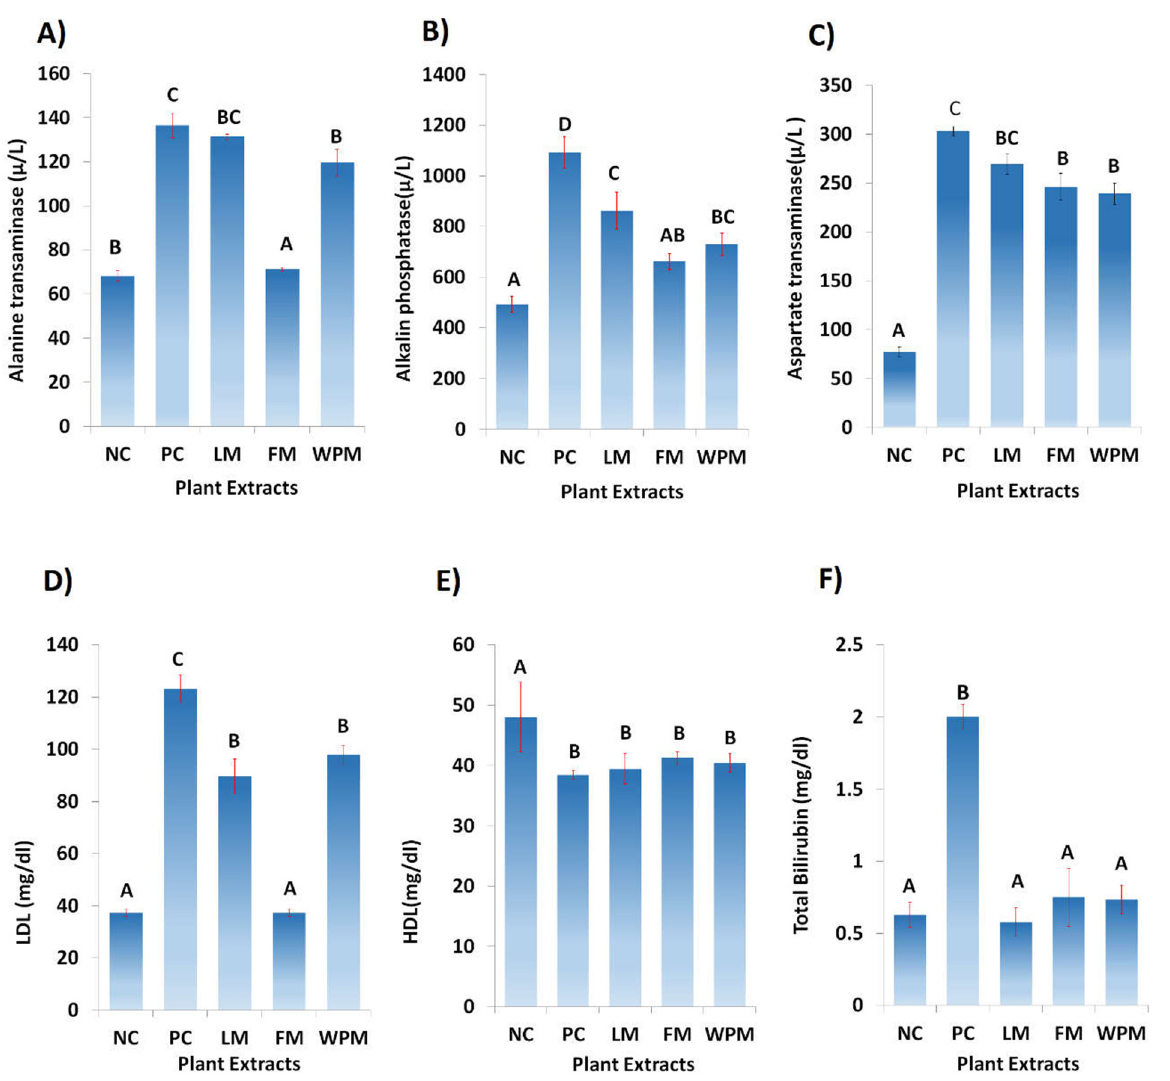
Figure 4. Effect of leaf, flower, and whole plant extract in contrast to negative and positive control (NC & PC) on serum lipid profile; ( A ) alanine transaminase, ( B ) alkaline phosphatase, ( C ) aspartate transaminase, ( D ) low density lipoprotein, ( E ) high density lipoprotein, and ( F ) total bilirubin. The different alphabet at chart bars showing significant difference.